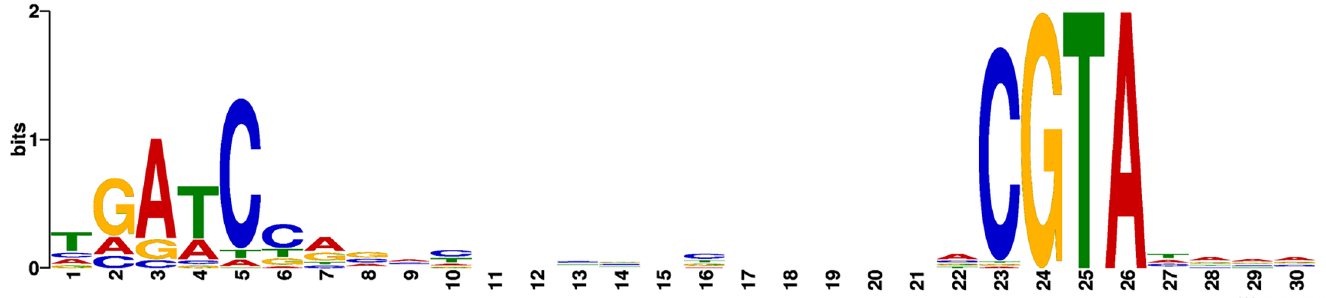
Fig 1. Promoter motif identified by MEME using the peaks identified by CSDeconv.